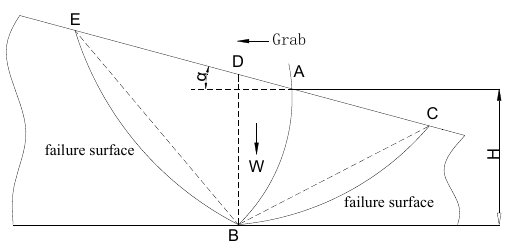
Figure 3. The failure surface of the material excavated by the grab.